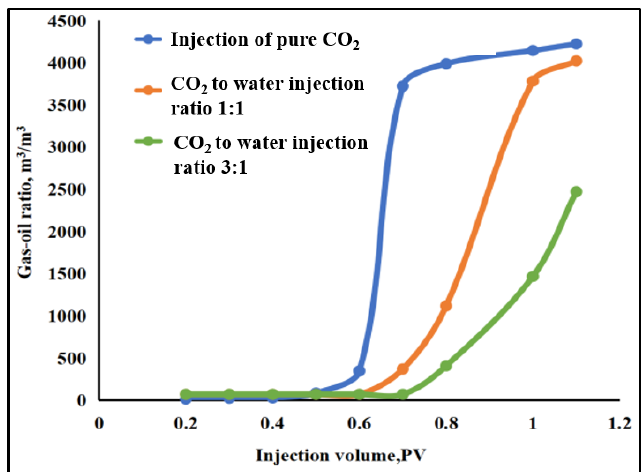
Figure 24. Gas – oil ratio at different injection ratios.